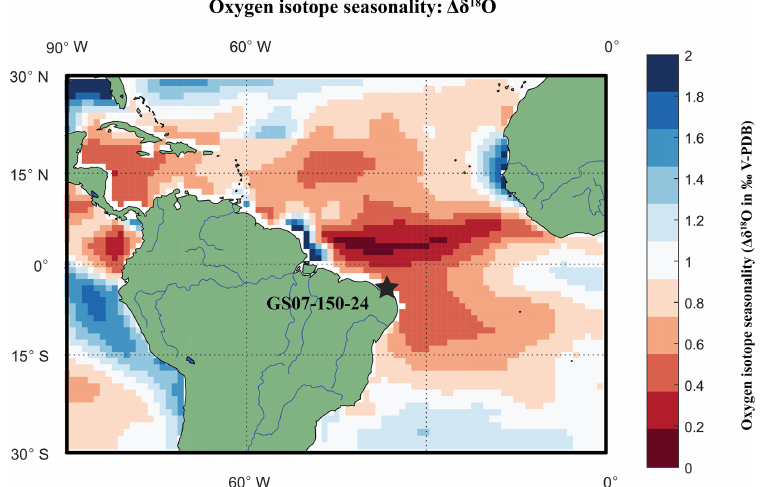
Figure 3. Location Map of RETRO multi-core GS07-150-24 plotted on a basemap of sea surface δ 18 O eq seasonality. Location of multi- core (black diamond) plotted on a seasonal oxygen isotope equilibrium ( (cid:49)δ 18 O) basemap, calculated by subtracting the maximum and the minimum ( δ 18 O eq ) of WOA13 temperature and salinity data converted into input variables for a rearranged (Kim and O’Neil, 1997) equation. Core location has an estimated (cid:49)δ 18 O of 0.6‰. Note that the coastline basemap of WOA13 is of a far lower resolution than Mathworks MatLab ® 2016 Mapping toolbox; thus, white areas around the coast represent a lack of